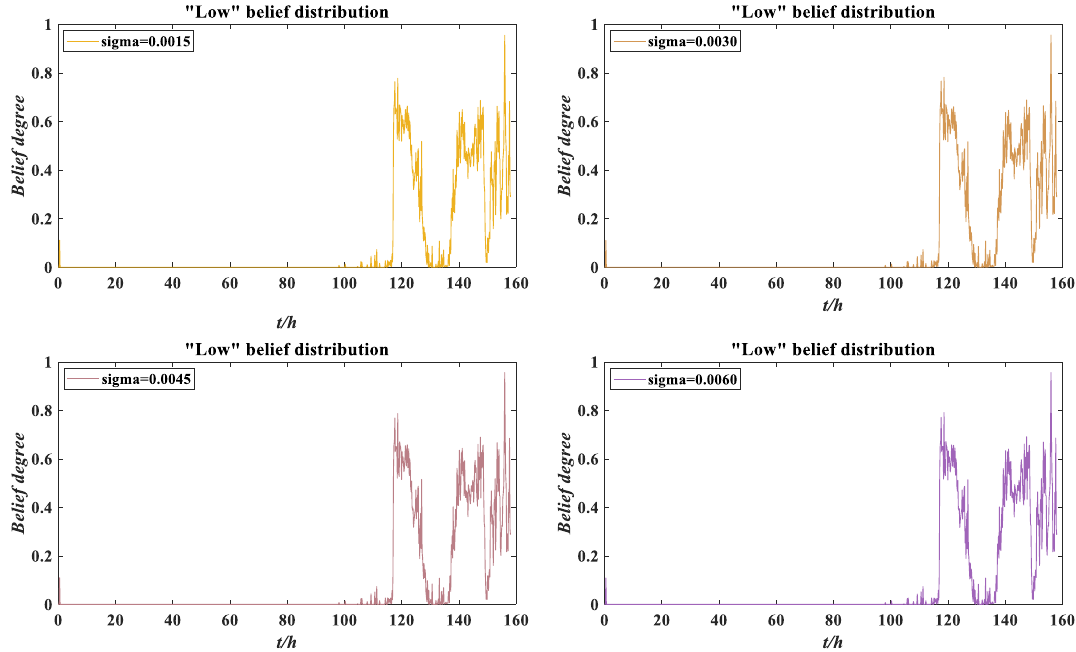
Figure 15. Low belief degree distribution of performance evaluation results under different perturbation Fig. 15. When the performance evaluation has a low belief degree and the expected utility fluctuates consider- ably, the perturbation coefficient is more likely to increase. This phenomenon indicates that when the indicator data fluctuate violently, it is more susceptible to the influence of perturbation conditions. Therefore, the rolling bearing should be adjusted or maintained to ensure its normal operation. Suppose that the maximum error of